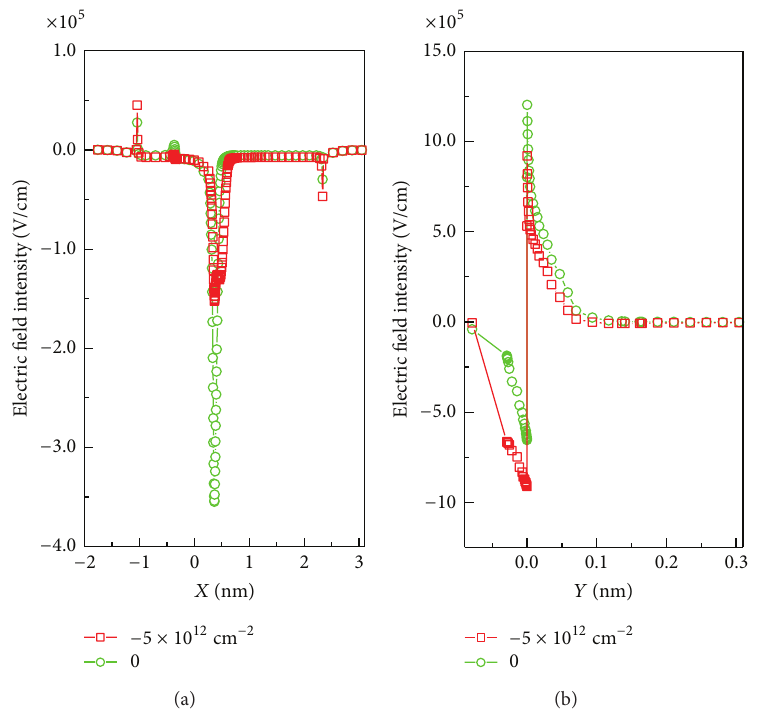
Figure 3: (a) Electric field intensity versus 𝑋 direction. (b) Electric field intensity versus 𝑌 direction.